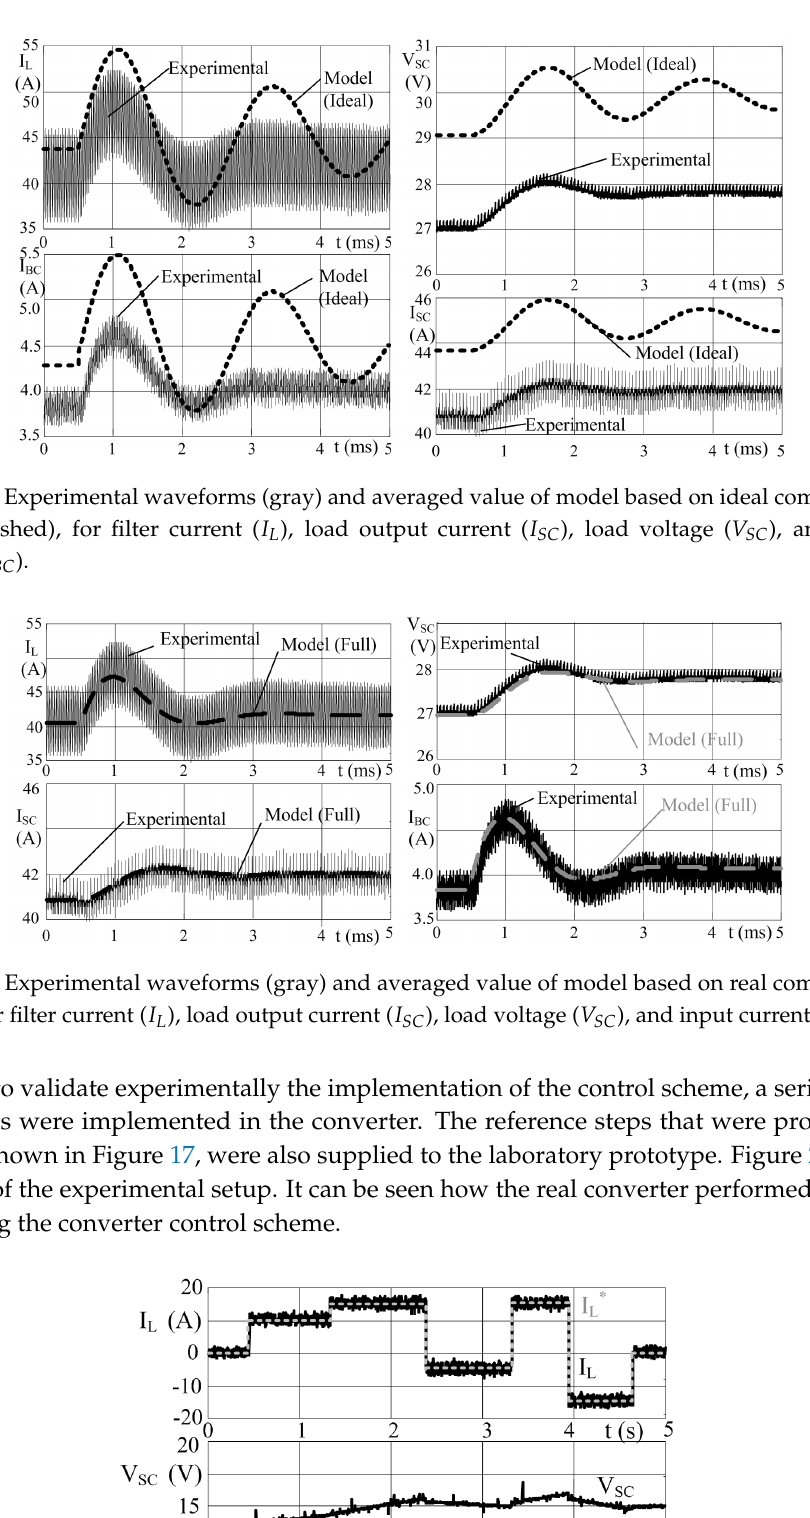
(referenced by dashed gray lines). Positive L